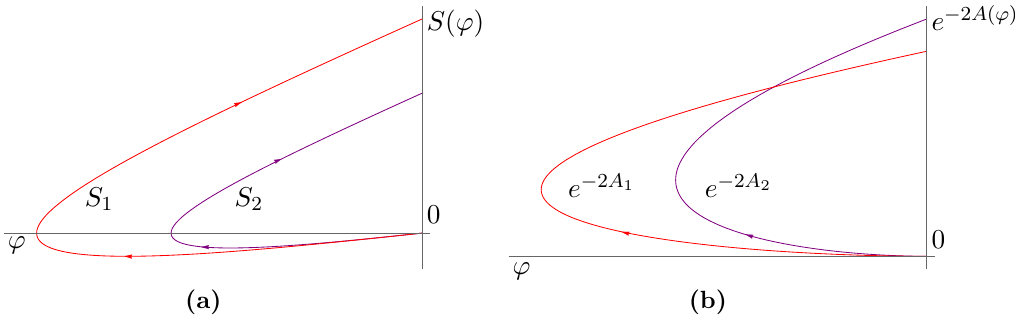
Figure 20. Plots of S 1 ; 2 ( ’ ) and e (cid:0) 2 A 1 ; 2 ( ’ ) corresponding to the two solutions W 1 ; 2 ( ’ ) in (cid:12)gure 19. The solutions are obtained for the potential (5.7) with (cid:1) + = 2 : 91, (cid:27) = 0 : 01, c = 2000, (cid:0) = p 2 = 3, ’ (cid:3) =